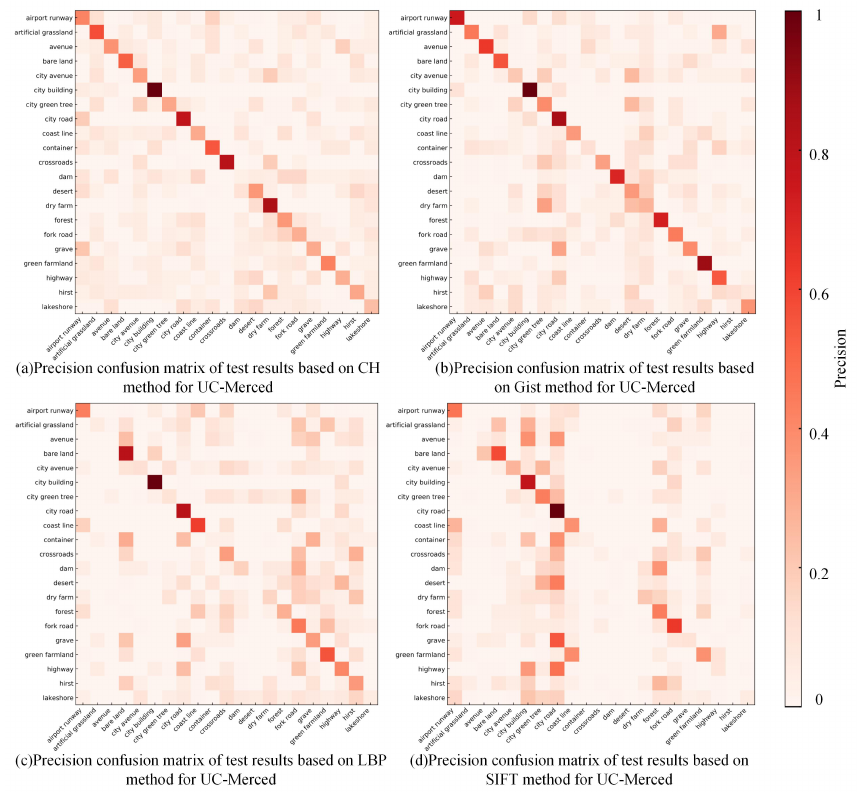
Figure 13. Precision confusion matrix of test results based on the handcrafted features for